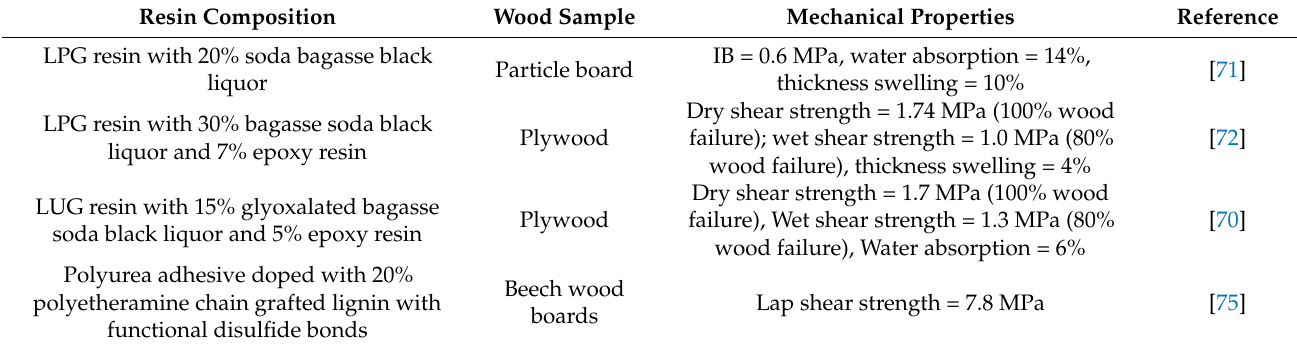
Table 3. Resin composition, sample type, and mechanical properties of selected resins on different basis than PF and UF described in literature. Resin Composition